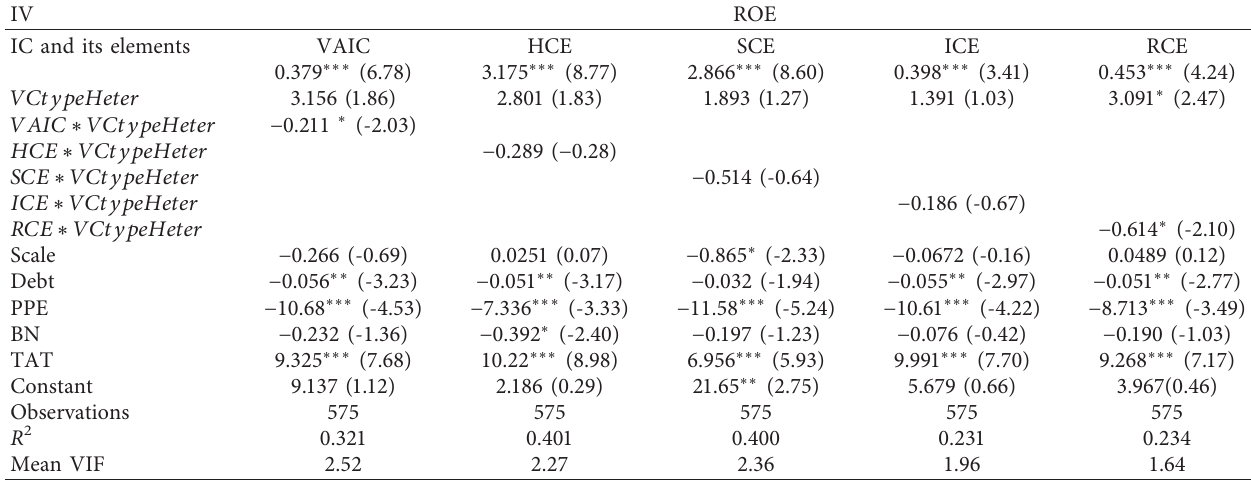
Table 12: Robustness check results of moderating effect of VCS member